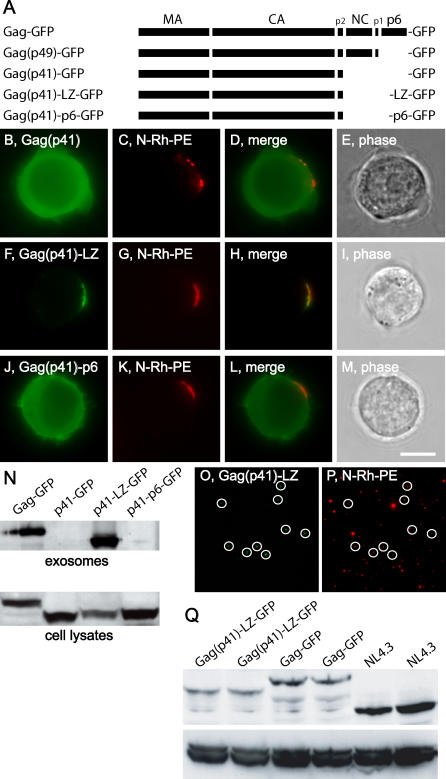
A Synthetic Leucine Zipper Can Suppress the Gag Budding Defect Caused by Loss of NC-p1-p6(A) Line diagram of full-length HIV Gag and mutant Gag-GFP proteins.(B–M) Fluorescence micrographs of N-Rh-PE–labeled Jurkat T cells expressing (B–E) HIV Gag(p41)-GFP, (F–I) HIV Gag(p41)-LZ-GFP, or (J–M) HIV Gag(p41)-p6-GFP.(N) Anti-Gag immunoblot of exosome and cell lysates of Jurkat T cells expressing (left lanes) full-length HIV Gag-GFP, (center left lanes) HIV Gag(p41)-GFP, (center right lanes) HIV Gag(p41)-LZ-GFP, and (right lanes) HIV Gag(p41)-p6-GFP, all loaded at the same ratio of exosome:cell lysate.(O and P) Fluorescence micrographs of exosomes secreted by N-Rh-PE–labeled Jurkat T cells expressing HIV Gag(p41)-LZ-GFP. White circles mark exosomes that contain both N-Rh-PE and Gag(p41)-LZ-GFP.(Q) Budding of p6-deficient Gag proteins is not an overexpression artifact. Jurkat T cells were transfected twice separately with (left two lanes) pcDNA3/HIVGag(p41)-LZ-GFP, (middle two lanes) pcDNA3/HIVGag-GFP, or (right two lanes) the HIV provirus NL4.3ΔEnv::GFPkdel. Two days later, the cells were lysed, and equal amounts of each lysate were processed for immunoblot using antibodies specific for (upper panel) HIV Gag, and (lower panel) Hsp90 (loading control). Bar indicates 10 μm.